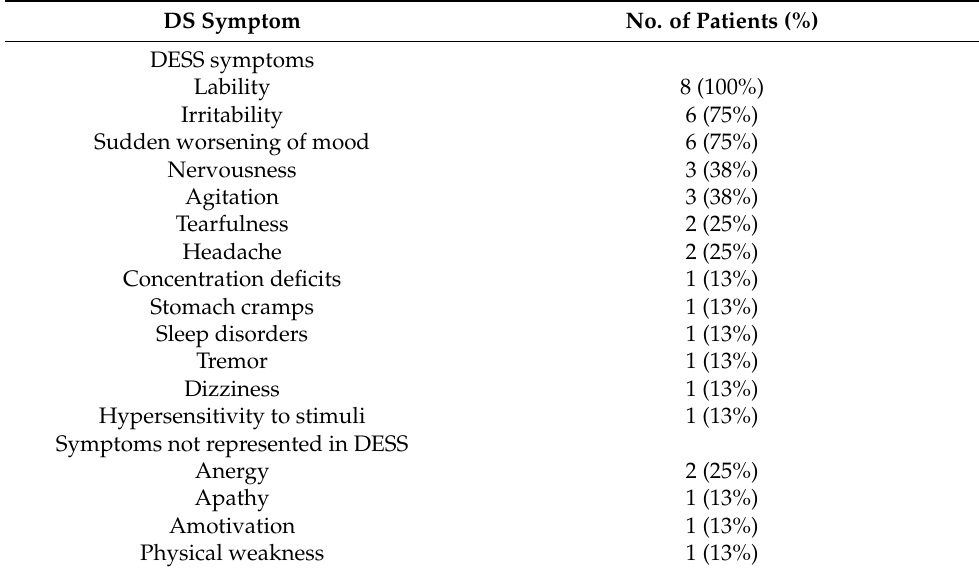
Table 2. Discontinuation symptoms after discontinuation of vortioxetine therapy. DS Symptom No. of Patients